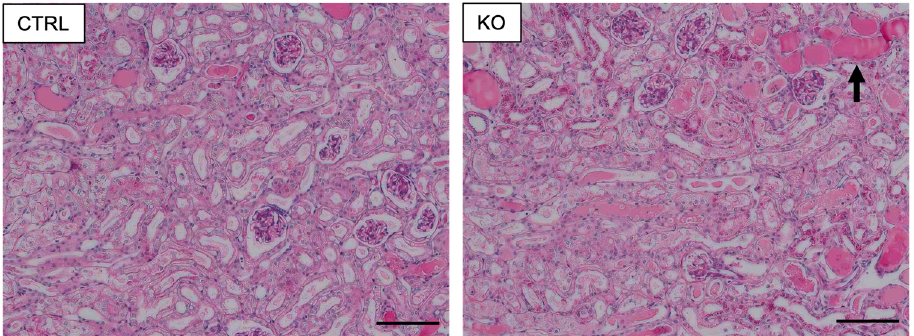
Figure 1. COUP-TFII -null animals exhibit more severe morphological abnormalities after cisplatin exposure. CTRL, control; KO, COUP-TFII knockout. The thyroid-like appearance in knockouts is indicated by an arrow. Scale bars: 100 µ m. Adapted with permission from Ishii et al. [71]. 2020, The Japan Endocrine